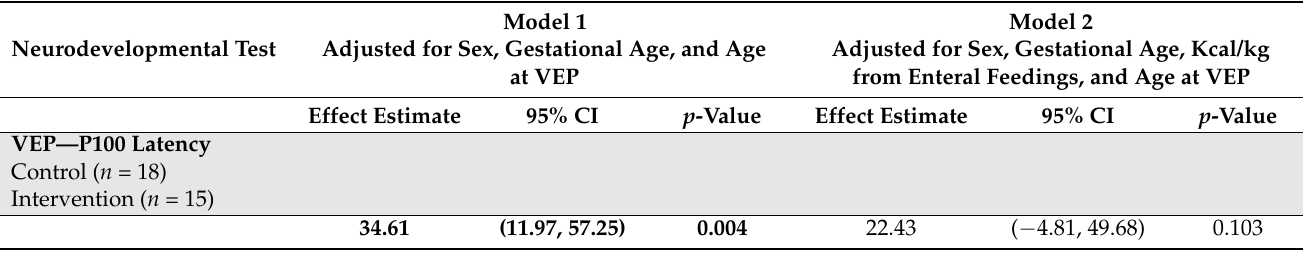
Table 5. Neurodevelopmental outcomes by randomization group with sensitivity analysis for attrition bias.